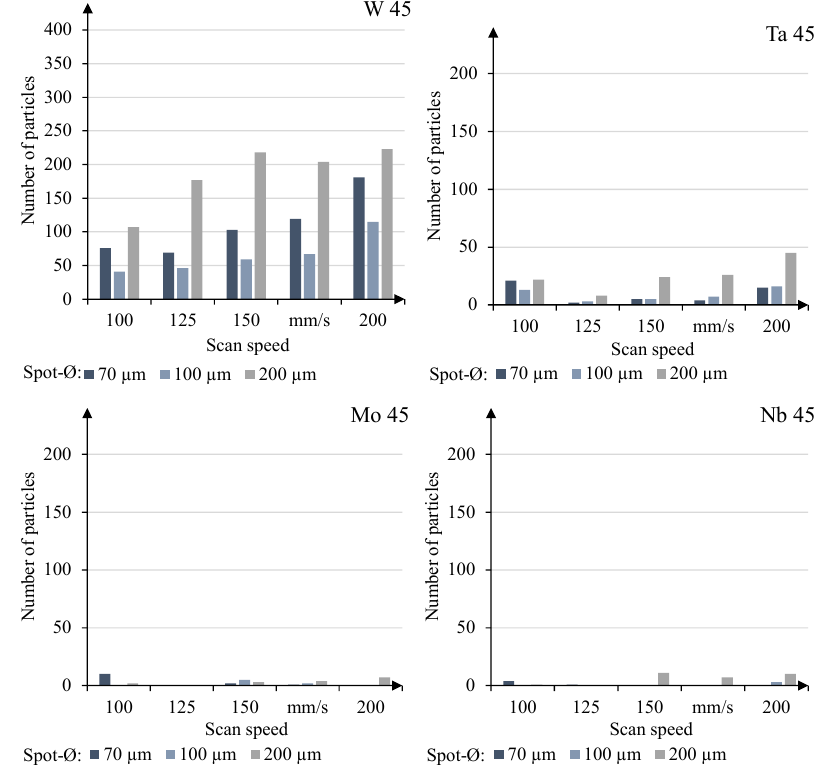
Figure A2. Results of experiments series 2 (also see Table 2); measurement area 3.8 mm 2 .